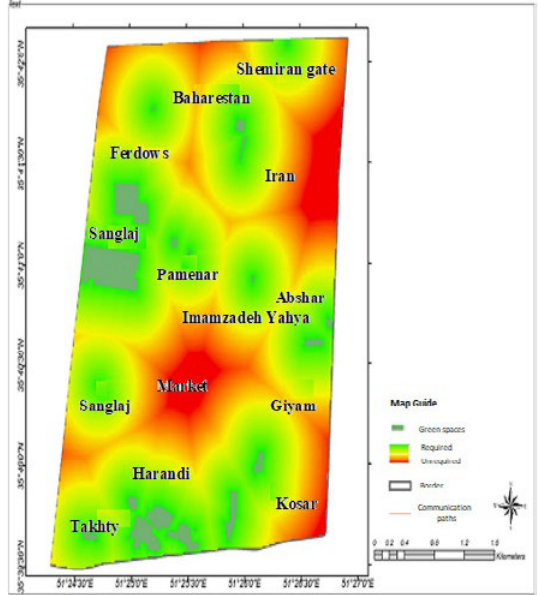
Fig. 21: The fuzzy layer of green spaces of the District the adjacent of these facilities and centers.